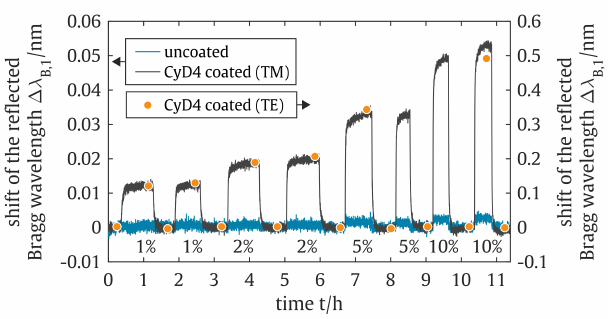
Figure 6. Shift of the reflected Bragg wavelengths for an uncoated PBG-sensor and the sensor coated with CyD4 to an increasing CFC-11 concentration. The discreetly recorded Bragg wavelength shift of the TE-mode reflection refers to the secondary